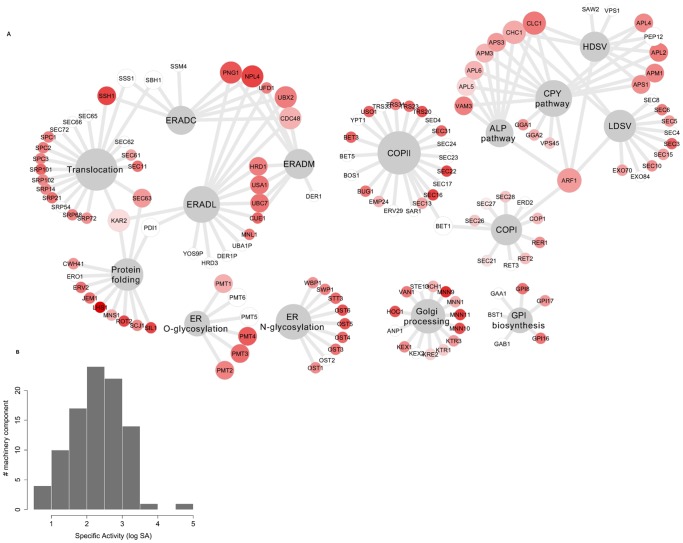
The specific activity (SA) network of the components of the yeast secretory machinery at exponential growth.The network representation of the machinery component SA (specific activity) in panel A shows how the components (circle nodes) are involved in one or various subsystems (diamond) processes. The graph is produced in Cytoscape [63] and the nodes color and size are weighed by the node degree and SA respectively (see Table S6 for Cytoscape input file).The logarithmic histogram (log10) of the SA (panel B) shows how the machinery components are distributed based on their specific activity.